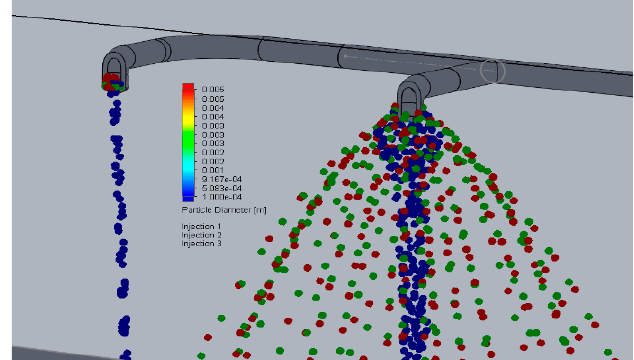
Figure 12. The pattern of liquid particle atomization formation.